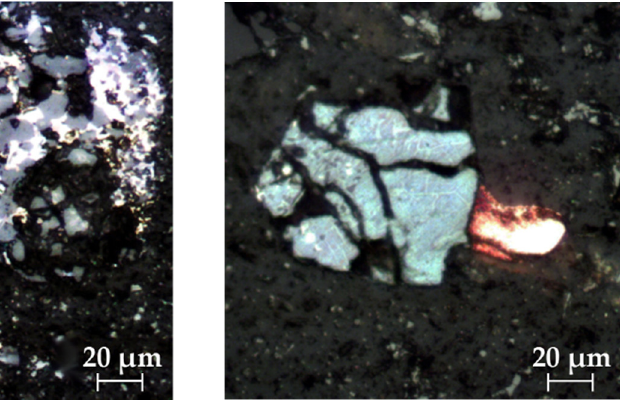
21 of 29 Figure 16. Particle size distribution and the cumulative size distribution for the sample prepared for the flotation process. Optical microscopy of sulfidized jarosite-PbAg sludge, with the addition of sulfur (sample no 1-68/32_S) presented in Figure 17, shows that sphalerite and galena exist in the